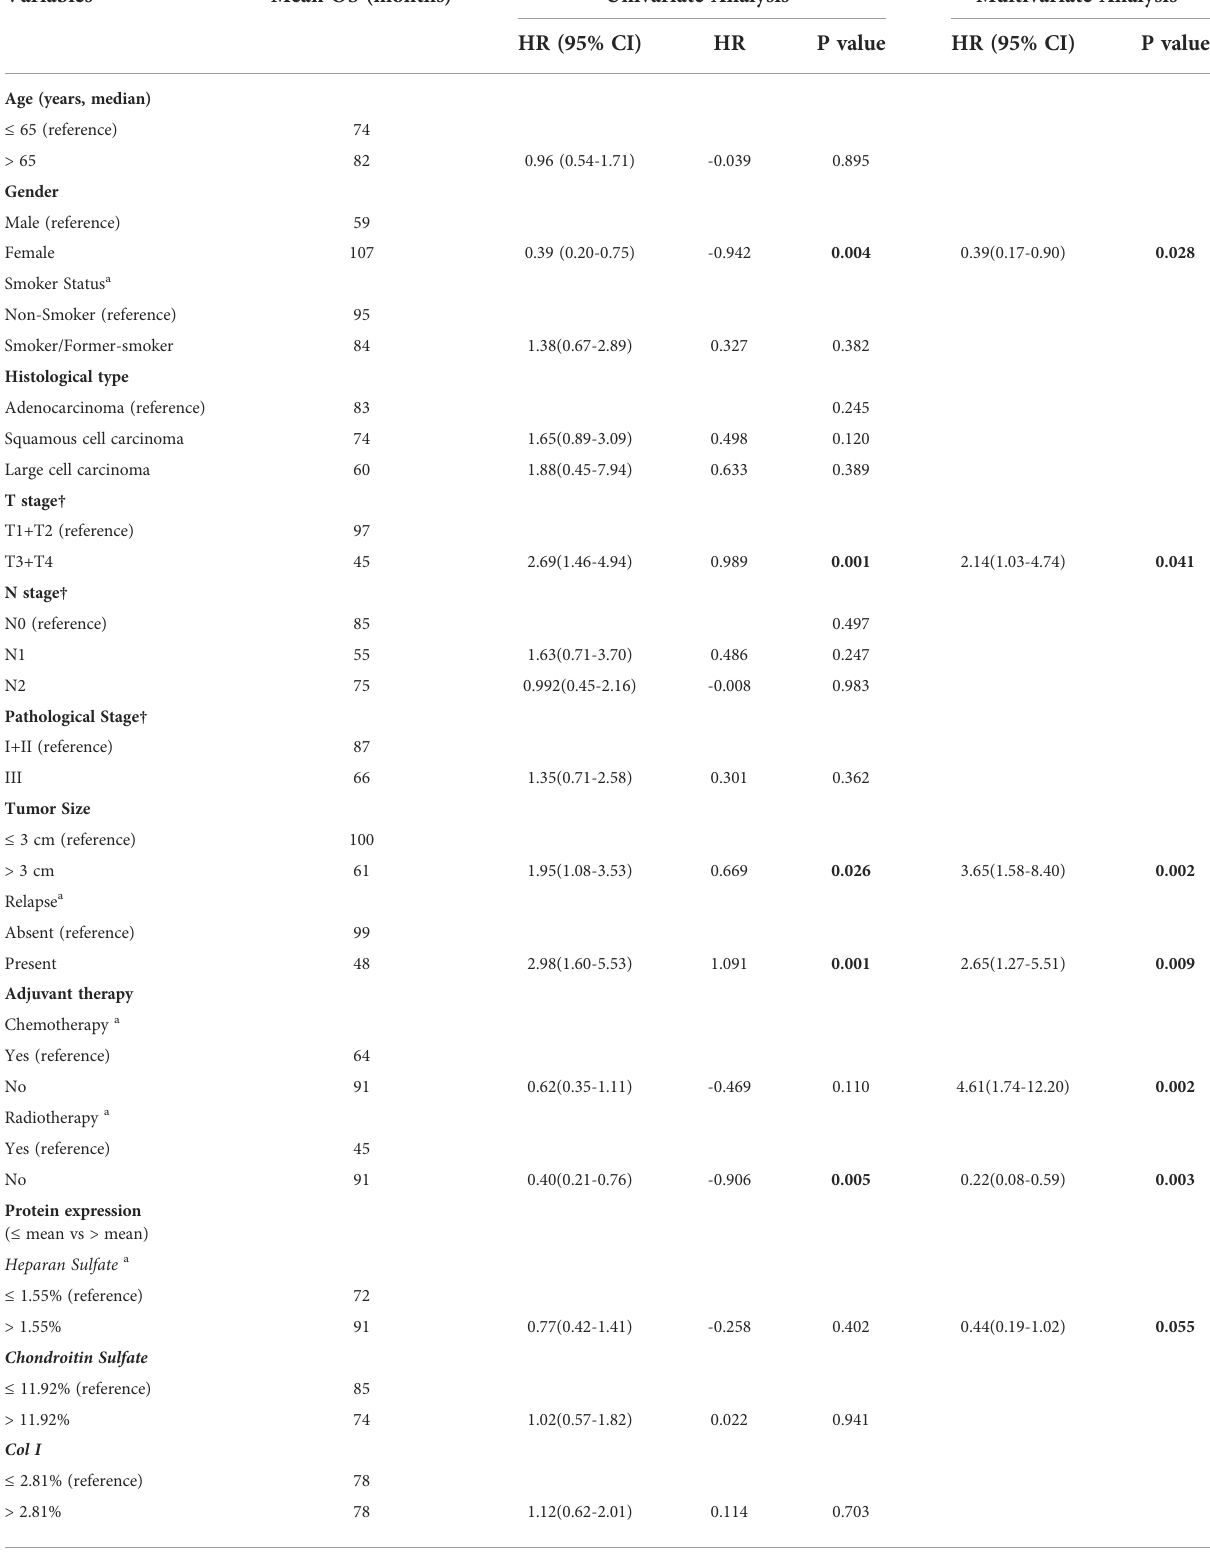
TABLE 4 Variables associated with overall survival in 120 non-small cell lung cancer